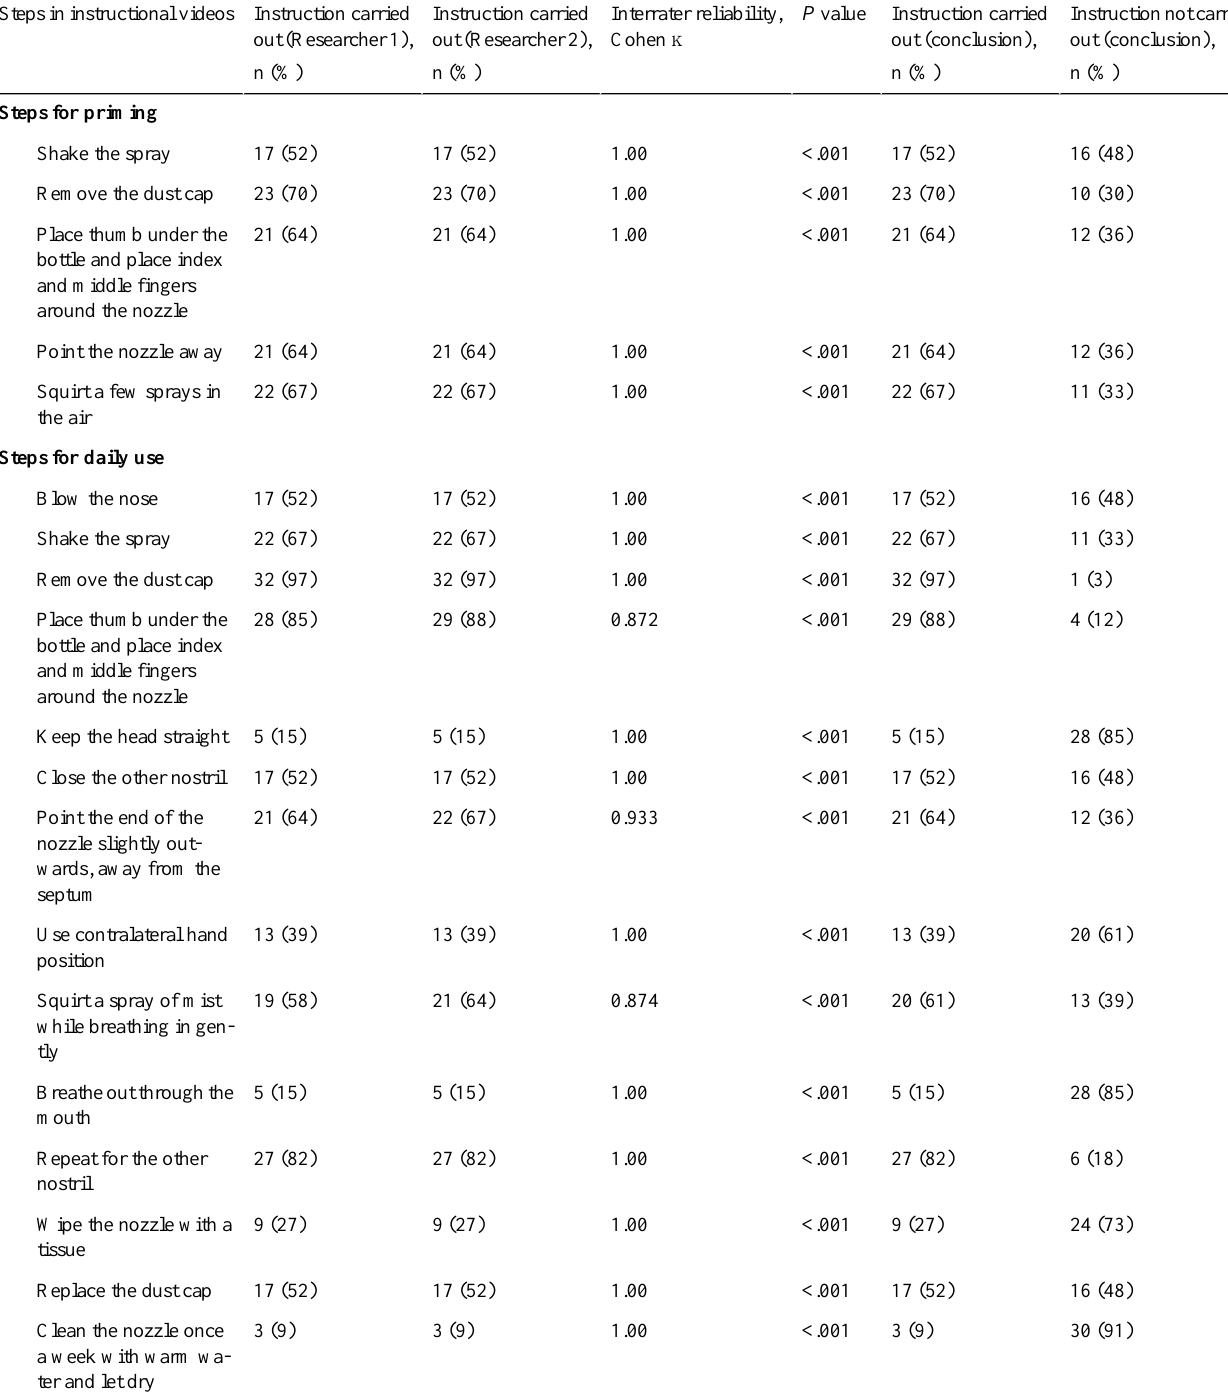
Table 2. Number of steps carried out correctly and incorrectly in the analyzed videos, based on the steps in the standardized Dutch protocol (N=33).